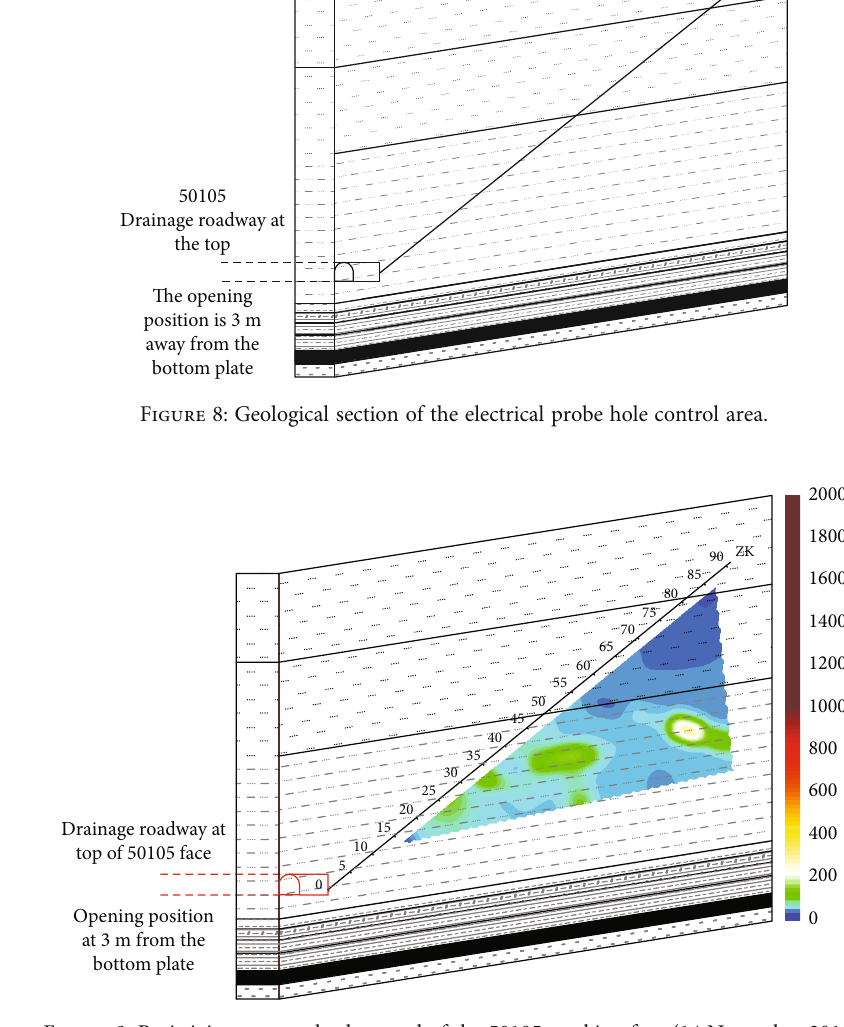
Figure 9: Resistivity contrast background of the 50105 working face (14 November 2019).